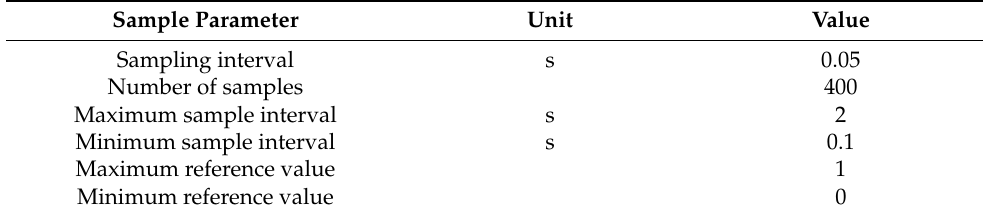
Table 3. MRC training sample